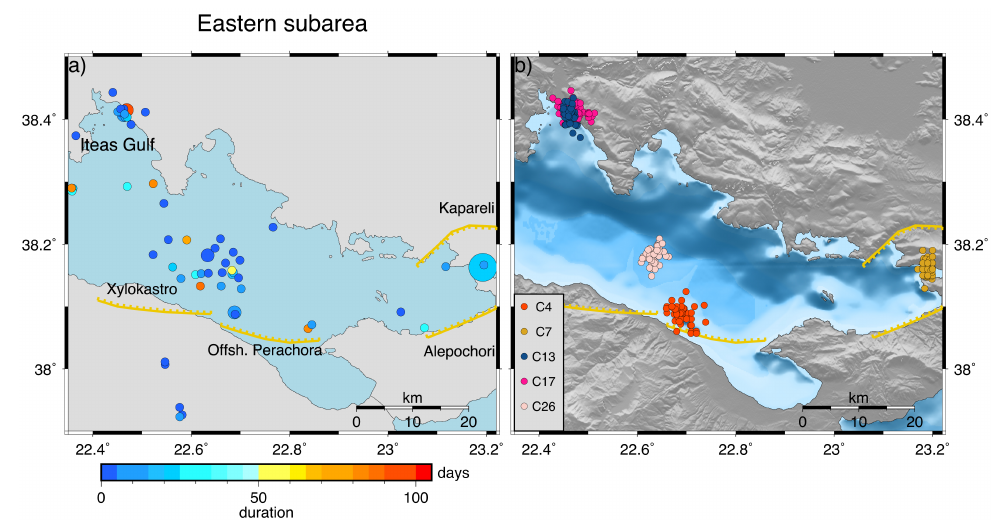
Figure 6. ( a ) Spatial distribution of the centroids of the identified clusters for the area of Central Ionian Islands along with the trace of the Kefalonia Transform Fault Zone (yellow lines). The size of the circles is proportional to the earthquake number in each cluster, whereas the duration is represented by the color scale. ( b ) Spatial distribution of the clusters with N ≥ 30 events. The index of each cluster is given in the inset